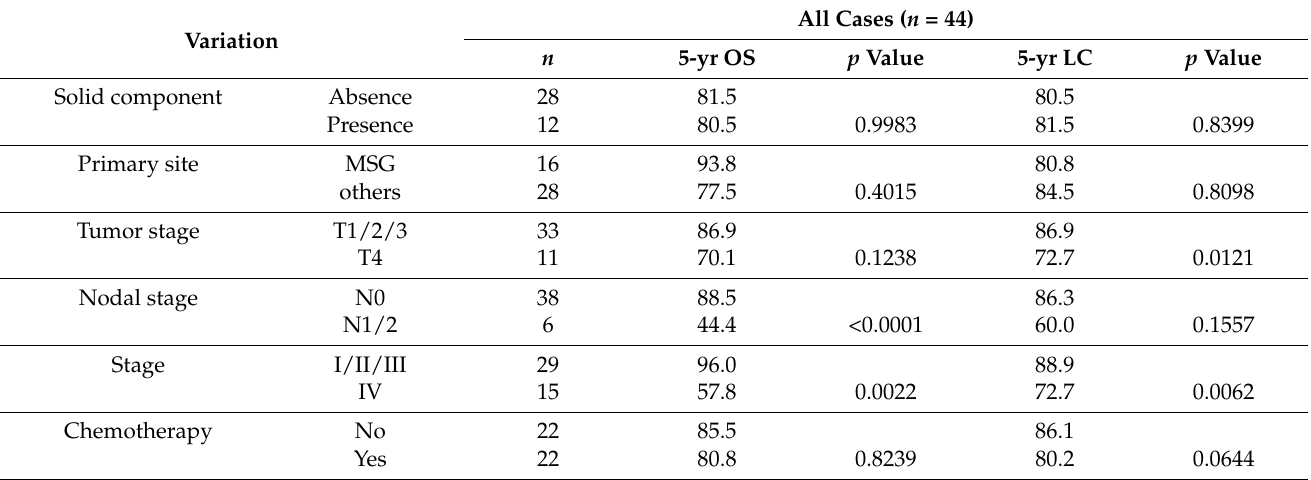
Table 2. Risk factors for overall survival and local control rates for all patients.